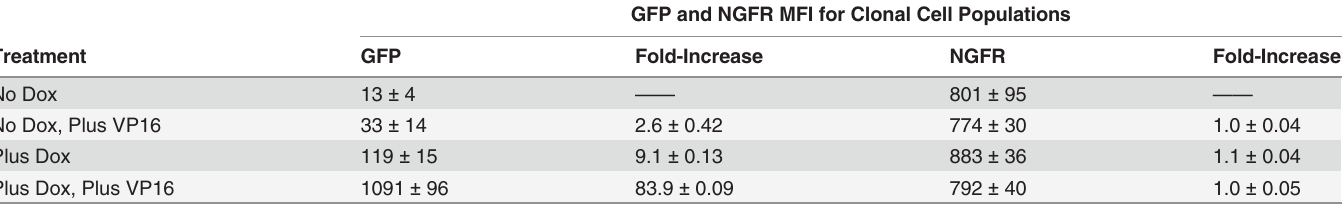
Table 4. Gene expression levels achieved using the inducible, HSV IE bidirectional